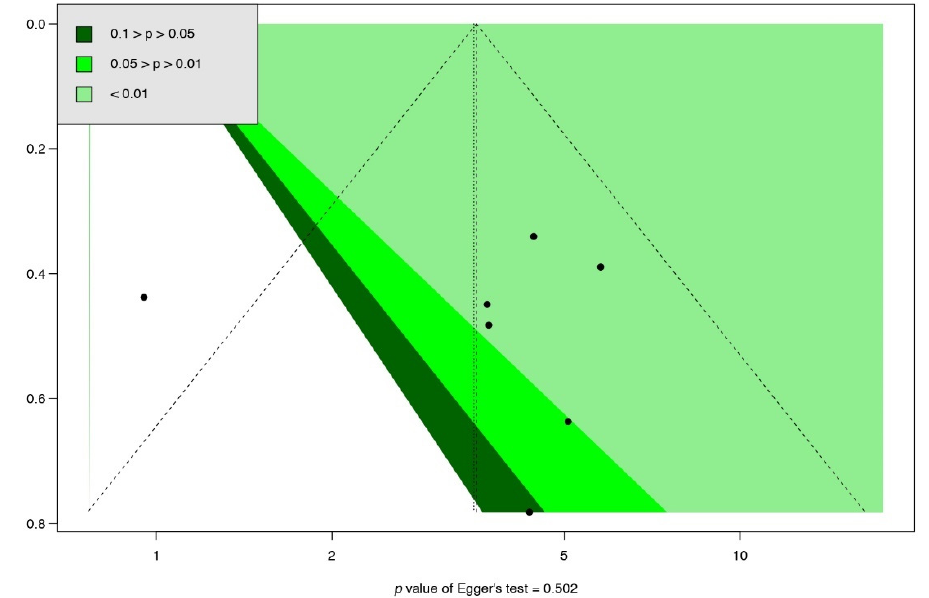
Figure A37. Comparison-adjusted funnel plot in outcome for initial stone free